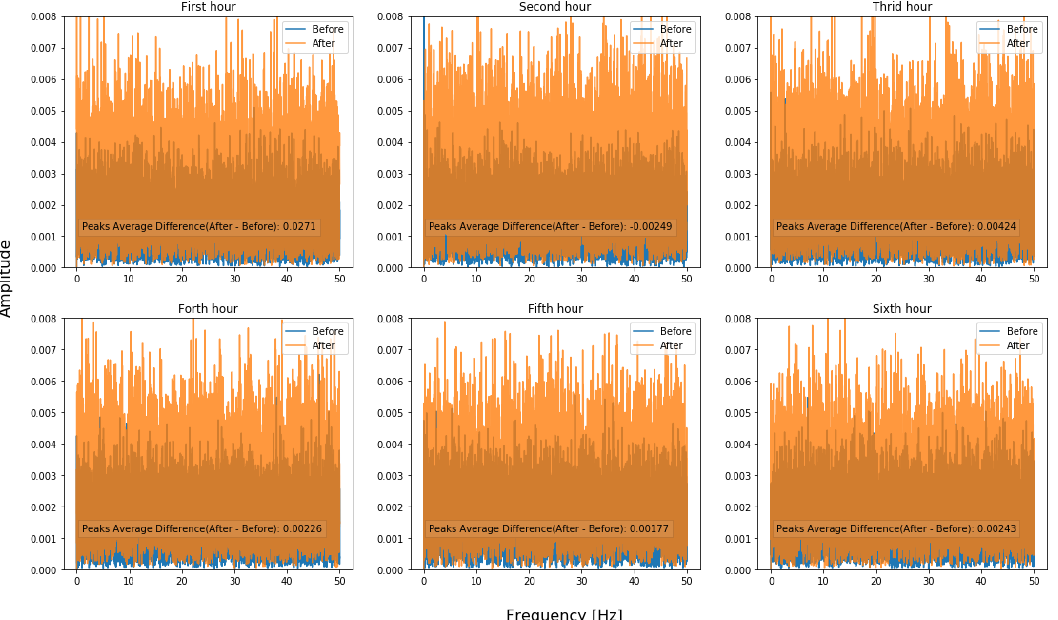
Figure 12. FFT Frequency domain plot for data collected from inside sensor before and after inserting Red Palm Weevils through